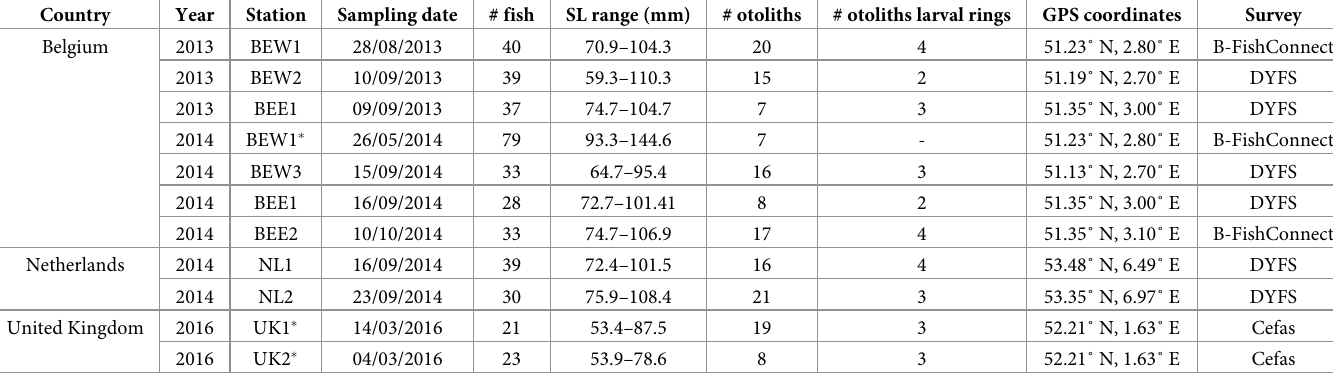
2.91˚ E (B2); Northeast coast 51.38˚ N, 3.22˚ E (B3)), the Dutch Directorate-General for Public Works and Water Management (recorded locations: 53.36˚ N, 6.91˚ E (B4) and 53.46˚ N, 6.84˚ E (B5)), and from Cefas in the UK (location 52.21˚ N, 1.63˚ E (B6)) (Fig 1). Coastal SST at the estimated settlement dates were calculated by averaging the two temperatures that were recorded closest to the date. In the case of the Netherlands, where data from two nearby buoys were available, SST recordings from both buoys were averaged to increase representativeness. Table 1. Origin, sampling date, GPS coordinates, sampling survey, overall number and size range (standard length) of all sampled sole per location, number of juvenile common sole selected for aging, and number of otoliths selected for reading larval